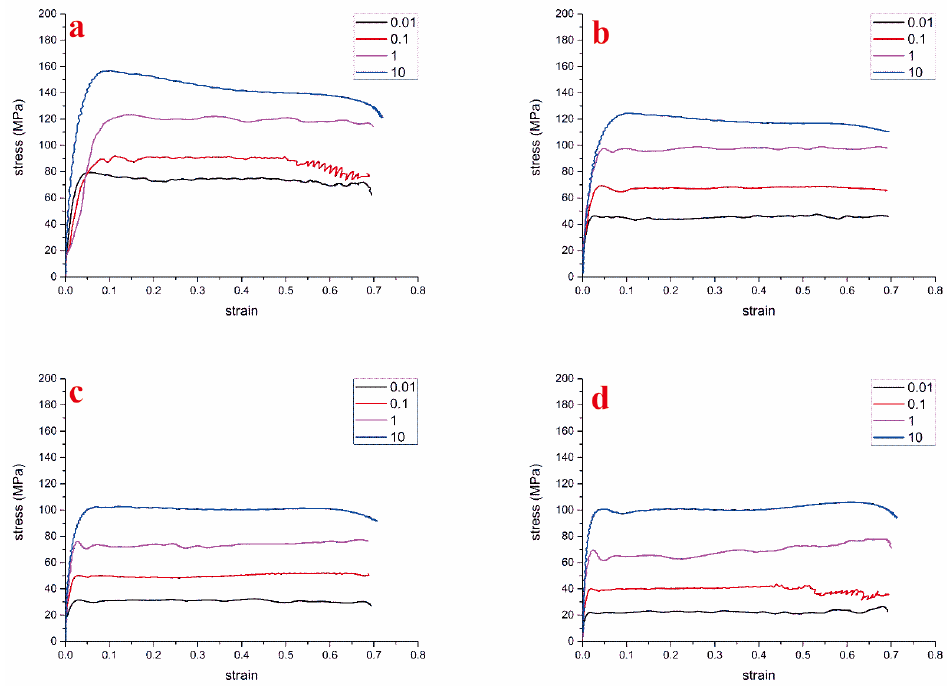
Figure 1. True stress–strain curve of 2A12 aluminum alloy material. ( a ) 360 °C; ( b ) 400 °C; ( c ) 440 °C; ( d ) 480 °C.